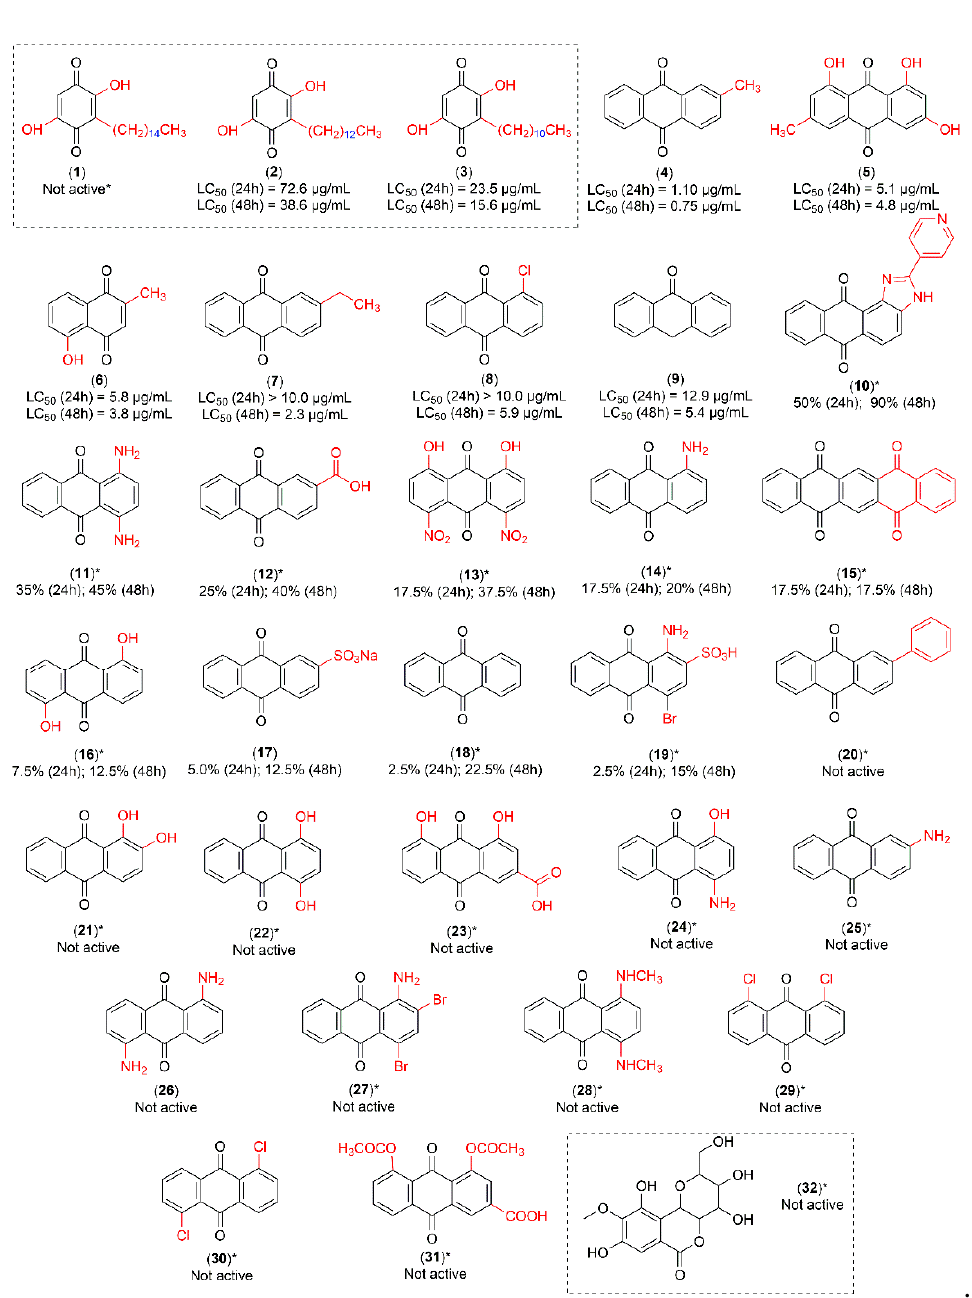
Figure 1. Quinone derivatives 1 – 31 : ( 1 ) suberonone; ( 2 ) rapanone; ( 3 ) embelin; ( 4 ) tectoquinone; ( 5 ) emodin; ( 6 ) plumbagin; ( 7 ) 2-ethylanthraquinone; ( 8 ) 1-chloroanthraquinone; ( 9 ) anthrone; ( 10 ) 2-(4-pyridil)-1 H -anthra[1,2- d ]imidazole-6,11-dione; ( 11 ) krisolamine; ( 12 ) anthraquinone-2-carboxylic acid; ( 13 ) 4,5-dinitrochrysazin; ( 14 ) 1-aminoanthraquinone; ( 15 ) 5,7,12,14-pentacenetetrone; ( 16 ) anthrarufin; ( 17 ) sodium anthraquinone-2-sulfonate; ( 18 ) anthraquinone; ( 19 ) bromaminic acid; ( 20 )2-phenylanthraquinone; ( 21 )alizarin; ( 22 )quinizarin; ( 23 )rhein; ( 24 )1-amino-4-hydroxyanthraquinone; ( 25 ) 2-aminoanthraquinone; ( 26 ) 1,5-diaminoanthraquinone; ( 27 ) dibromoaminoanthraquinone; ( 28 ) 1,4-bis(methylamino)anthraquinone; ( 29 ) 1,8-dichloroanthraquinone; ( 30 ) 1,5-dichloroanthraquinone and ( 31 ) diacerein. C -glycoside derivative of gallic acid: ( 32 ) bergenin. All compounds tested against Ae. aegypti larvae at 25 µ g / mL. LC 50 values were only determined for compounds causing ≥ 80% mortality after 24 h ( 2 – 9 ). * Compounds with mortality percentages < 80% after 24